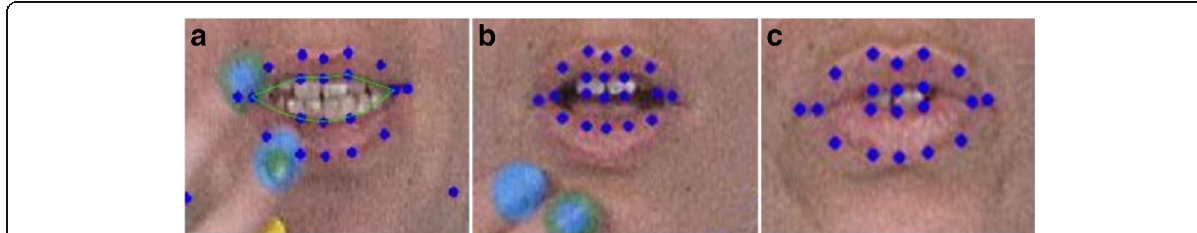
Fig. 4 Examples of 20 CLNF landmarks placed in the full lips region. Eight points describe the inner lips contour. a Good inner lips contour of CLNF with hand occlusion. The green curve is the inner lips contour using interpolation. b Mistaken CLNF landmarks in the case of the B parameter). c Mistaken CLNF two end landmarks for round open inner lips (mistaken A